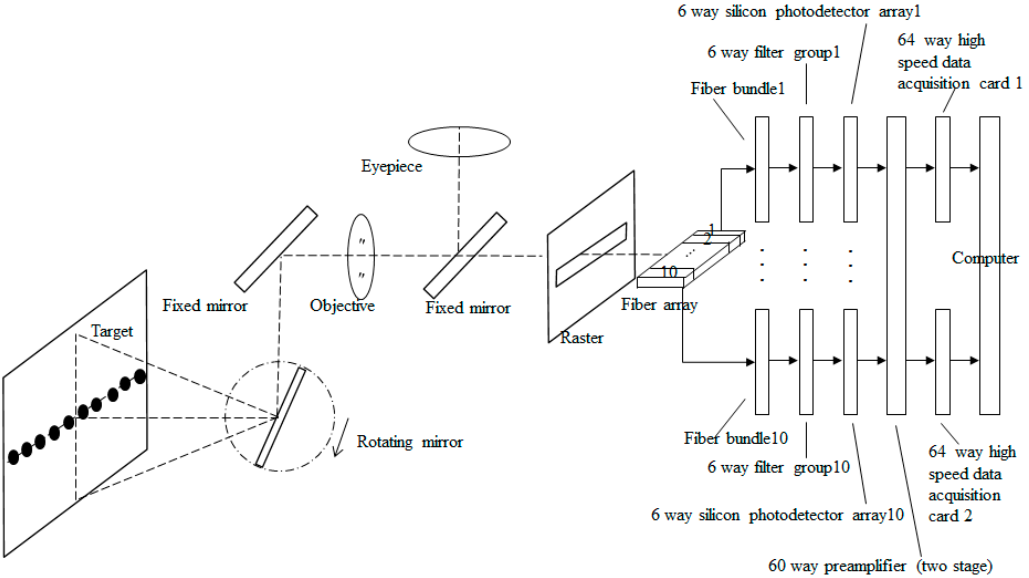
Figure 2. A block diagram of the two-dimensional array pyrometer.